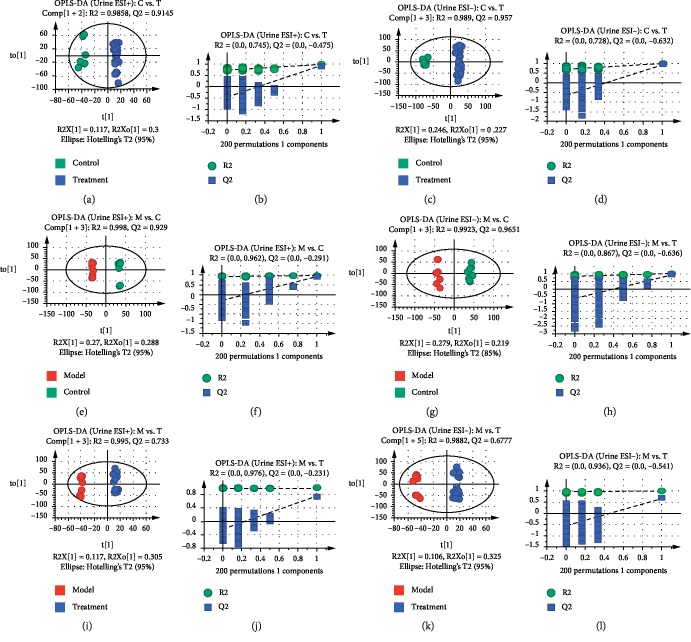
OPLS-DA score plots and permutation test results of metabolomics analysis based on urine samples: results between the control group and the RWCI treatment groups in the ESI+ mode (a, b) and in the ESI− mode (c, d); results between the model group and the control group in the ESI+ mode (e, f) and in the ESI− mode (g, h); results between the model group and the RWCI treatment groups in the ESI+ mode (i, j) and in the ESI− mode (k, l). All P values were less than 0.01, calculated by the CV-ANOVA test.